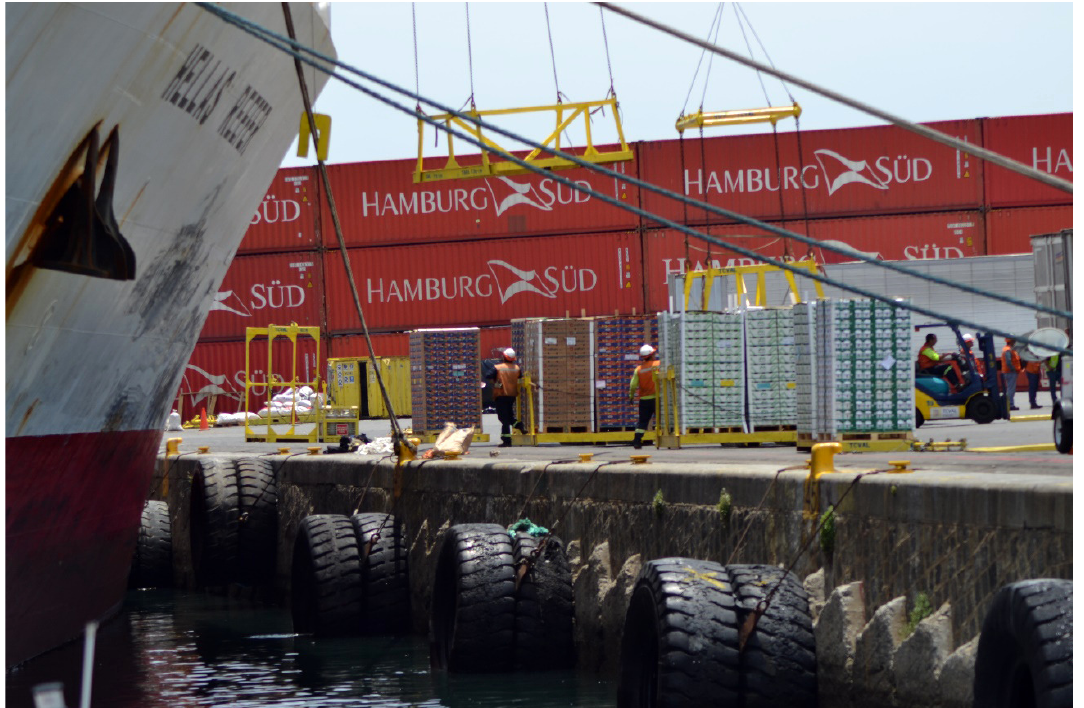
Figure 12. Dockworkers embarking a reefer vessel in Valparaíso’s Terminal 2 (TCVAL). Source: Hernán Cuevas (photograph taken circa 2016).